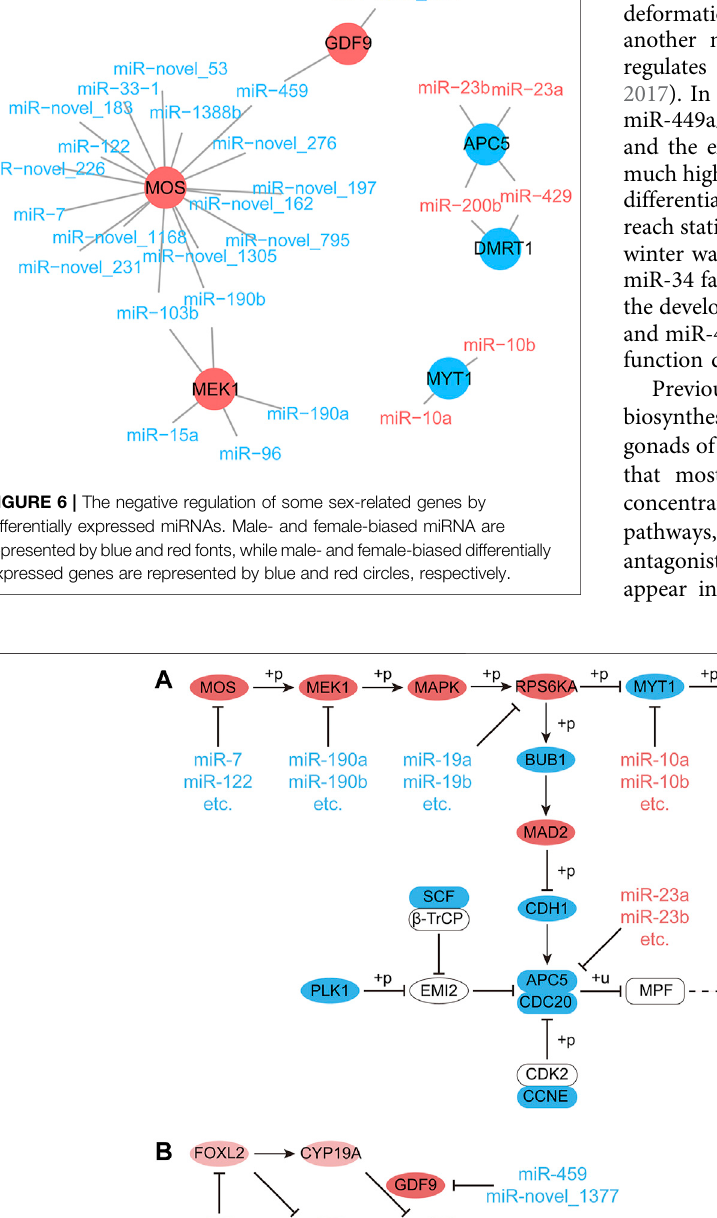
Frontiers in Genetics |